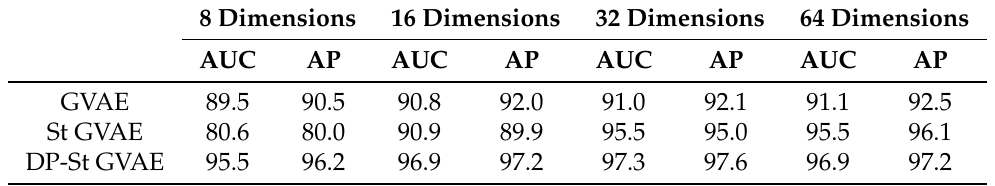
Table 3. Link prediction performance comparison of different dimensions for Citeseer.